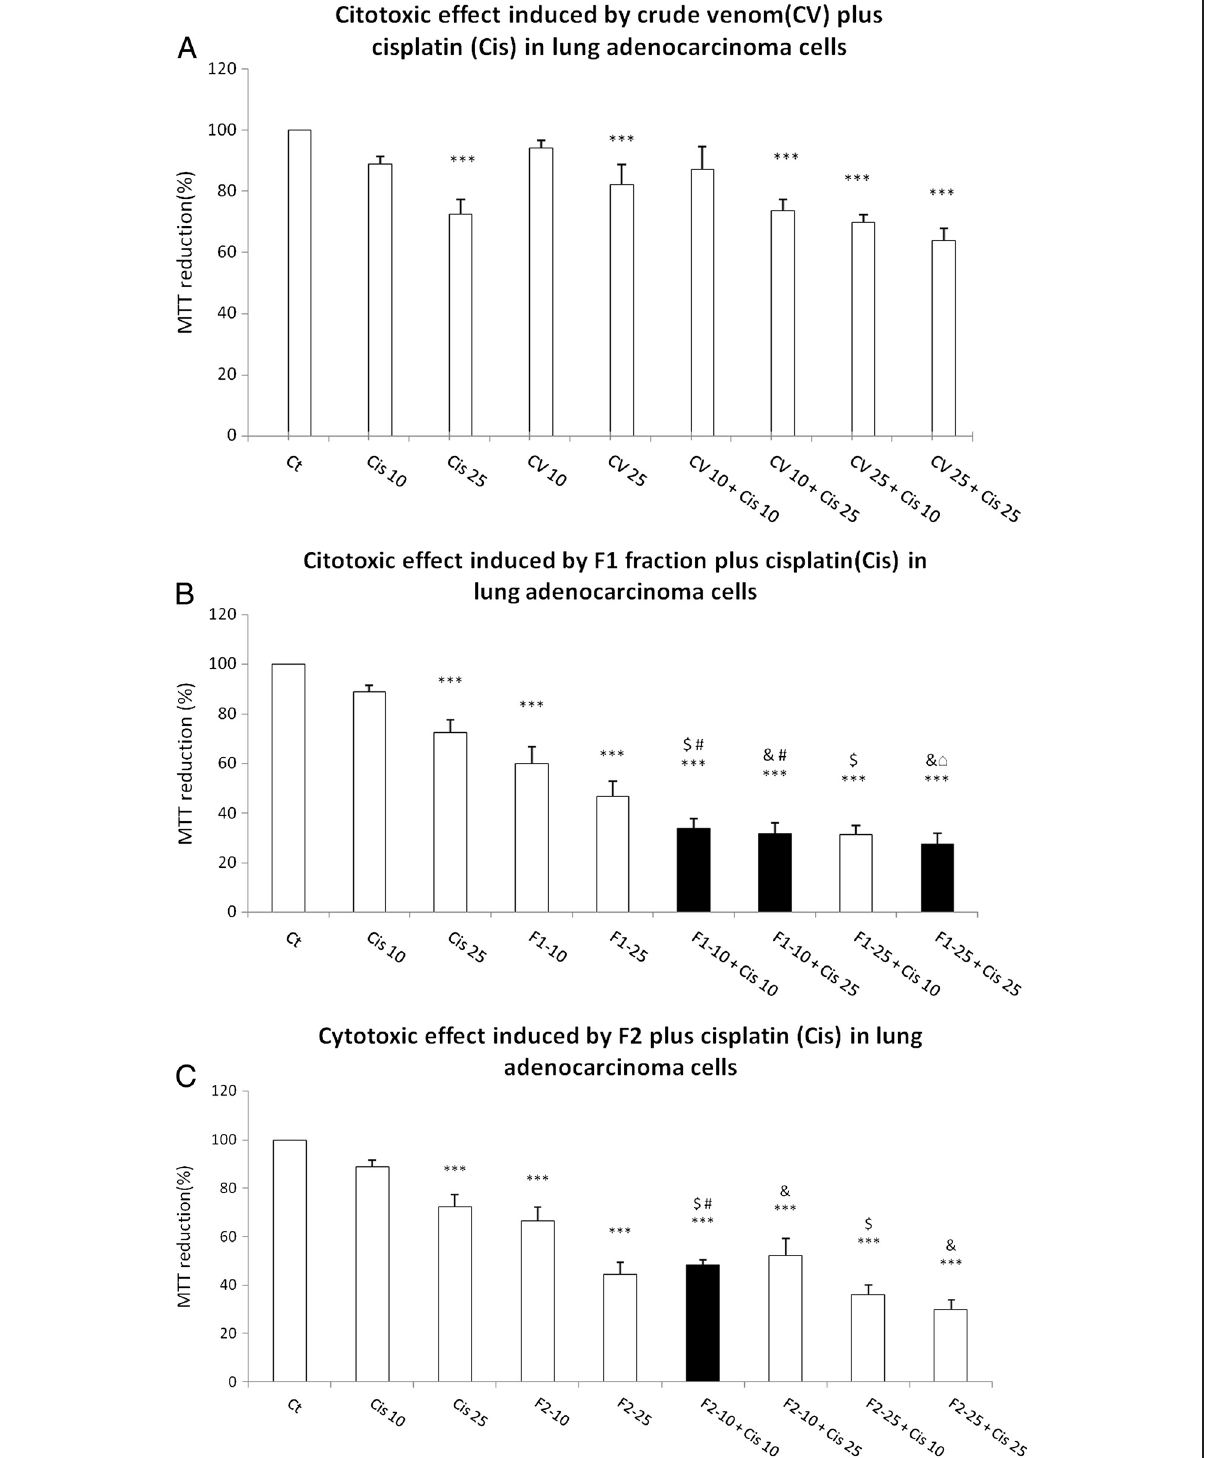
Figure 4 Cytotoxic effect induced by CV, F1 and F2 fraction from B. globulifera on adenocarcinoma lung cell culture. ( A ) CV, ( B ) F1 fraction plus cisplatin, ( C ) F2 fraction plus cisplatin. Graphs show the percentage of MTT reduction and data are expressed as the mean ± SD of four independent experiments. *** p < 0.001 vs. control, $ p < 0.001 vs. Cis 10, & p < 0.001 vs. Cis 25, # p < 0.001 vs. CV 10 or F1-10 or F2-10, □ p < 0.001 vs. CV 25 or F1-25 or F2-25 (One-way analysis of variance plus Bonferroni ’ s test). Gray bars show the ability of ( B ) F1 and ( C ) F2 to augment the cisplatin decrease in MTT